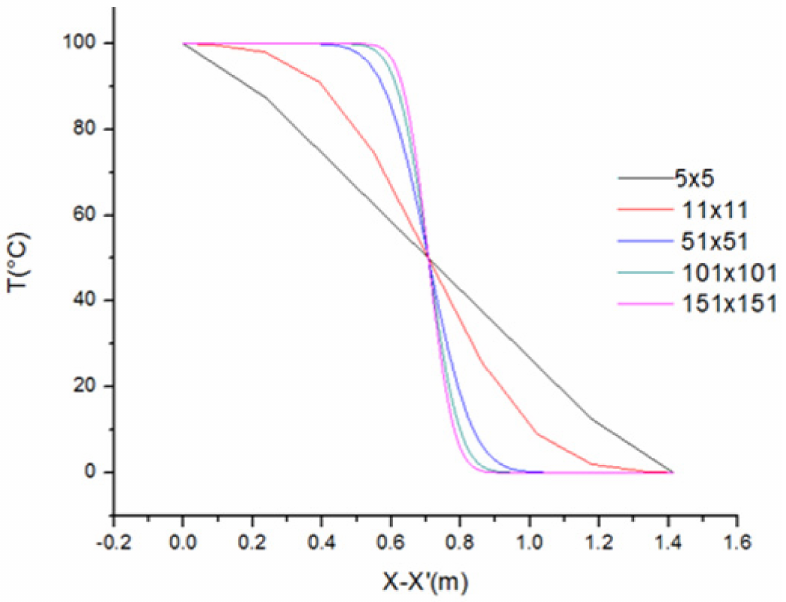
Figure 3. Temperature profile for CASE 1: Convection-diffusion